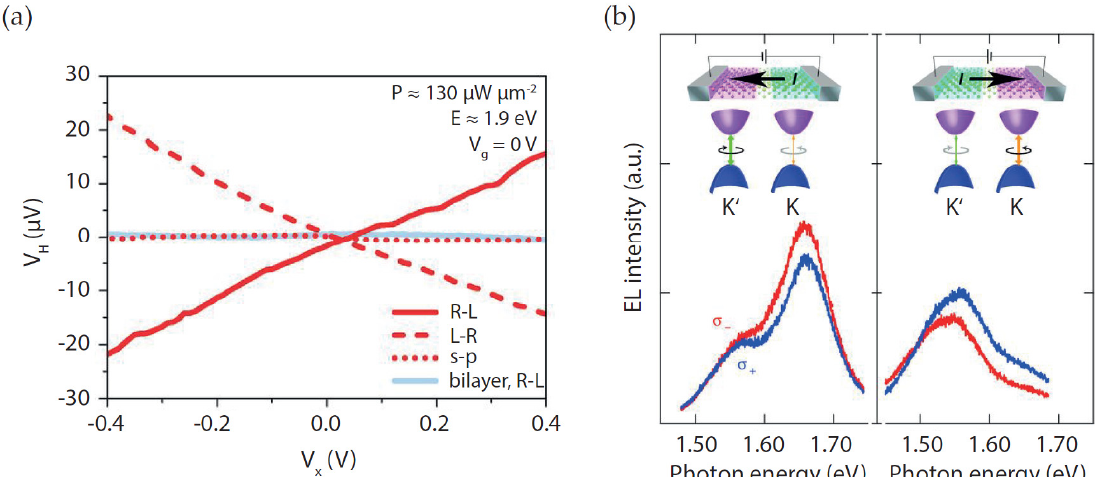
Figure 9. ( a ) Source drain bias dependence ( V x ) of the Hall voltage ( V H ) for a monolayer MoS 2 device for different light polarizations demonstrating the valley Hall effect. Reproduced with permission from [114], Copyright The American Association for the Advancement of Science, 2014. ( b ) Lateral p-n diode with opposite current flow direction (top) and corresponding dominant excitonic emission (bottom), representing the contribution to electroluminescence from K and K 1 valleys. Reproduced with permission from [65], Copyright The American Association for the Advancement of Science,